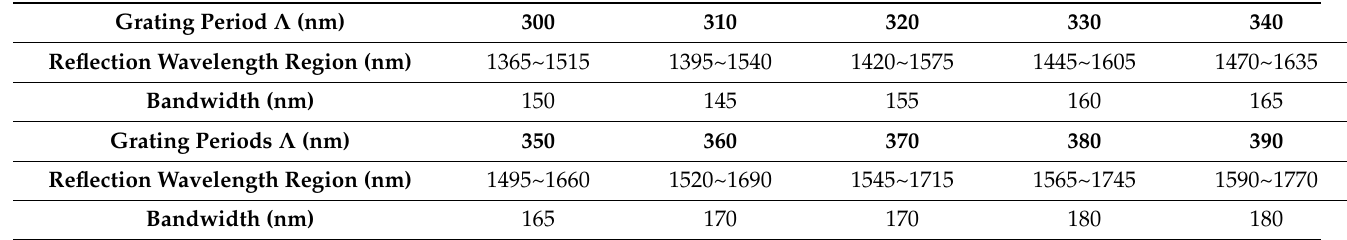
Table 1. TE reflection wavelength region and the bandwidth of the proposed polarizer.